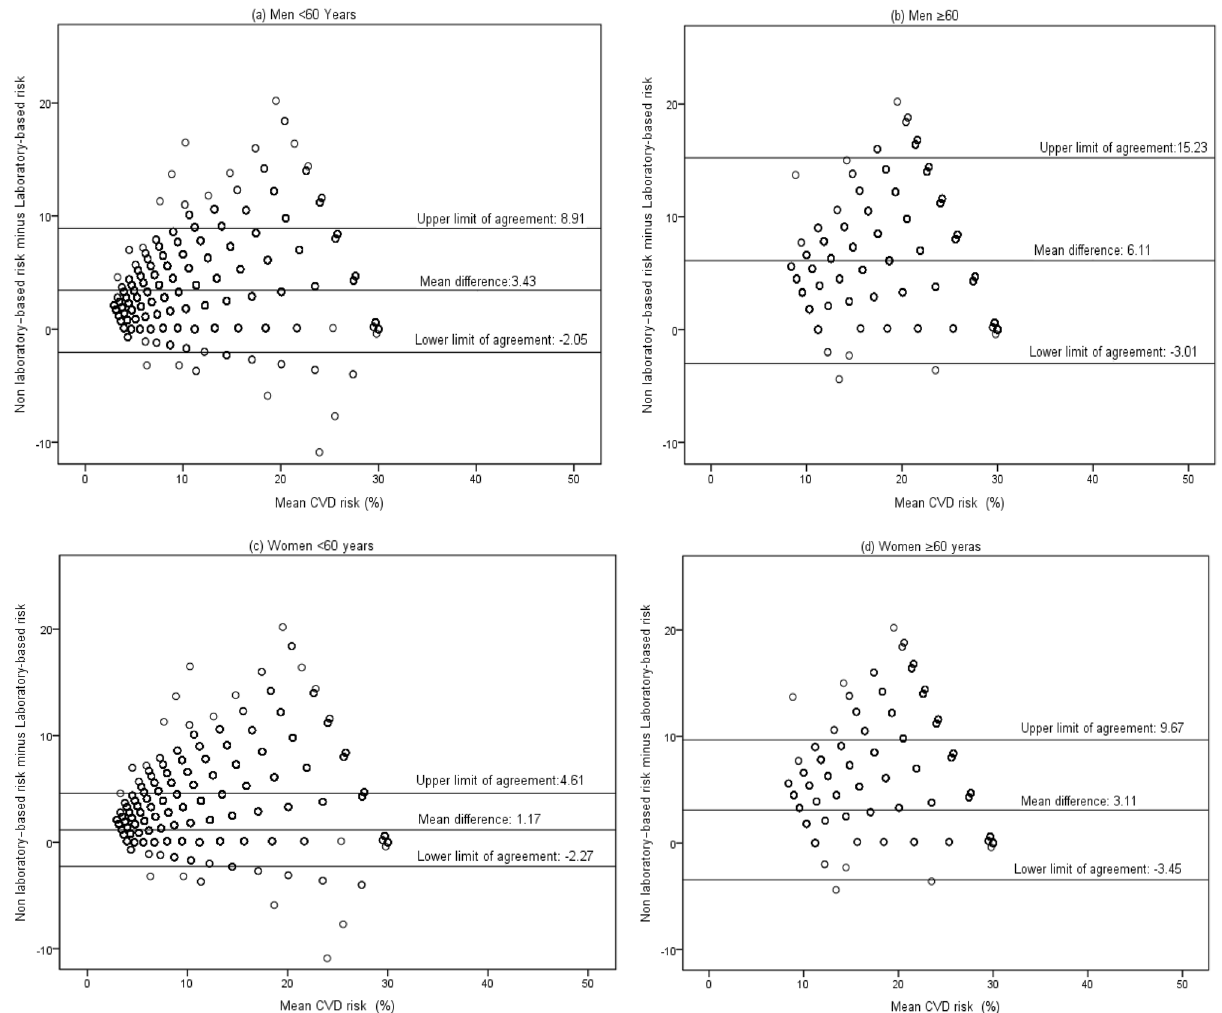
Figure 1. Bland–Altman plots showing agreement between the laboratory-based and non-laboratory-based CVDs risk Mean differences in risk scores. Among all participants, the mean difference between the laboratory- based and non-laboratory-based scores was 2.69% (95% CI: 2.63% to 2.76%), which was 3.97% (95% CI: 3.86% to 4.08%) for males and 1.58% (95% CI: 1.51% to 1.64%) for females. The mean difference in scores was 2.23% (95% CI: 2.16% to 2.29%) among the participants < 60 years old and 4.48% (95% CI: 4.28% to 4.68%) among those ≥ 60 years old. The mean difference of the scores was also calculated based on the age groups. Accordingly, the mean dif- ference of the scores was 3.43% (95% CI: 3.33% to 3.52%) in the males < 60 years old, 6.11% (95% CI: 5.79% to 6.44%) among the males ≥ 60 years old, 1.17% (95% CI: 1.11% to 1.23%) in the females < 60 years old, and 3.11% (95% CI: 2.90% to 3.32%) among the females ≥ 60 years old. Bland–Altman plots/limits of agreement. Bland Altman plots of the agreement between the two risk scores for males and females < 60 and ≥ 60 years old have been presented in Fig. 1. Accordingly, the limit of agreement was better for females < 60 years old compared to females ≥ 60 years old, males < 60 years old, and males ≥ 60 years old. The limit of agreement was −2.27% to 4.61% for females < 60 years old, 9.67% to -3.45% for females ≥ 60 years old, -2.5% to 8.91% for males < 60 years old, and -3.01% to 15.23% for males ≥ 60 years old. The limit of agreement was wider for males ≥ 60 years old in comparison to other groups. Categorical agreement. In the total research population, the agreement of the two risk scores was 78.79%. The agreement between the two risk scores according to the risk score categories in males and females has been presented in Tables 2 and 3, respectively. For males, the agreement between the risk scores was equal to 66.43% (kappa = 0.42, Standard Error (SE) = 0.01). It should be noted that there was a larger number of participants in the high-risk group for the non-laboratory-based model than in the laboratory-based model (733 vs. 320). Disagreement was observed in both low-risk and high-risk groups. Non-laboratory-based risk groups tended to